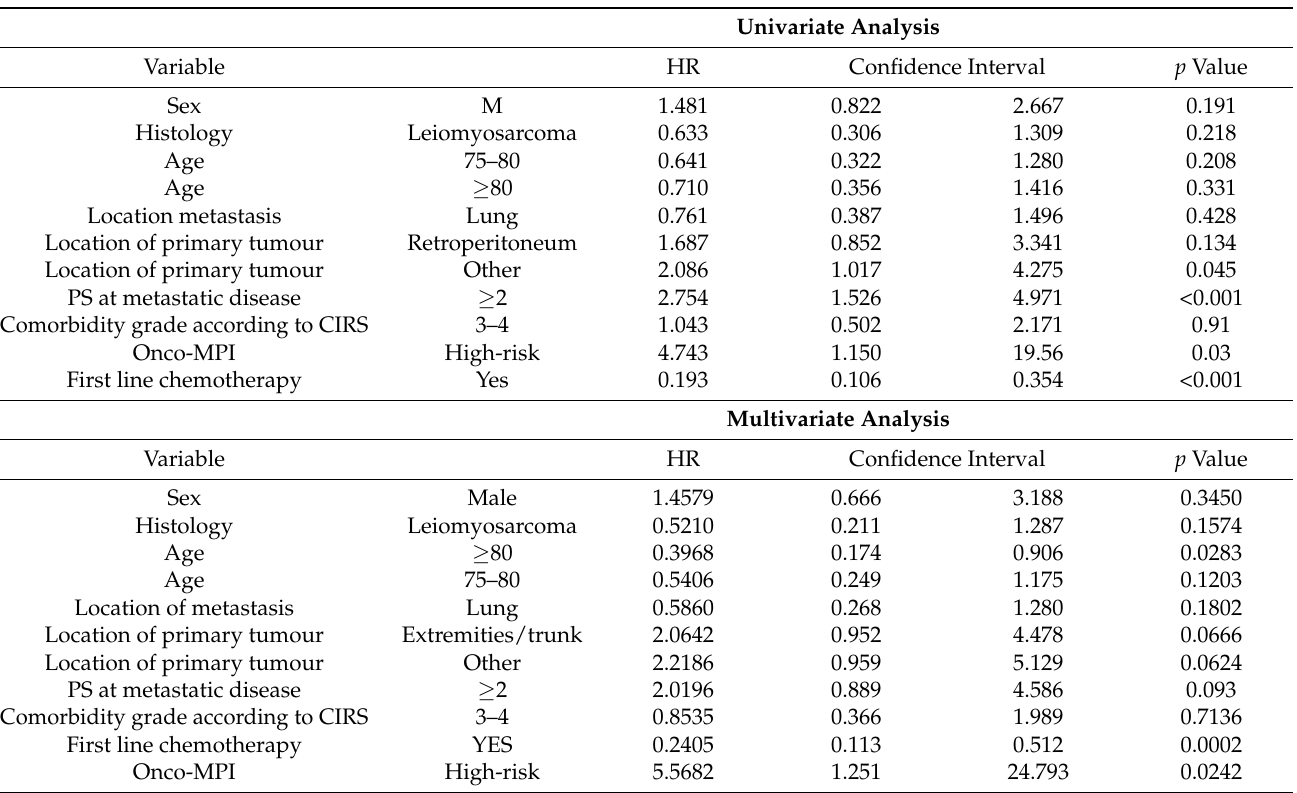
Table 6. Univariate analysis and multivariate analysis for one-year survival. Univariate